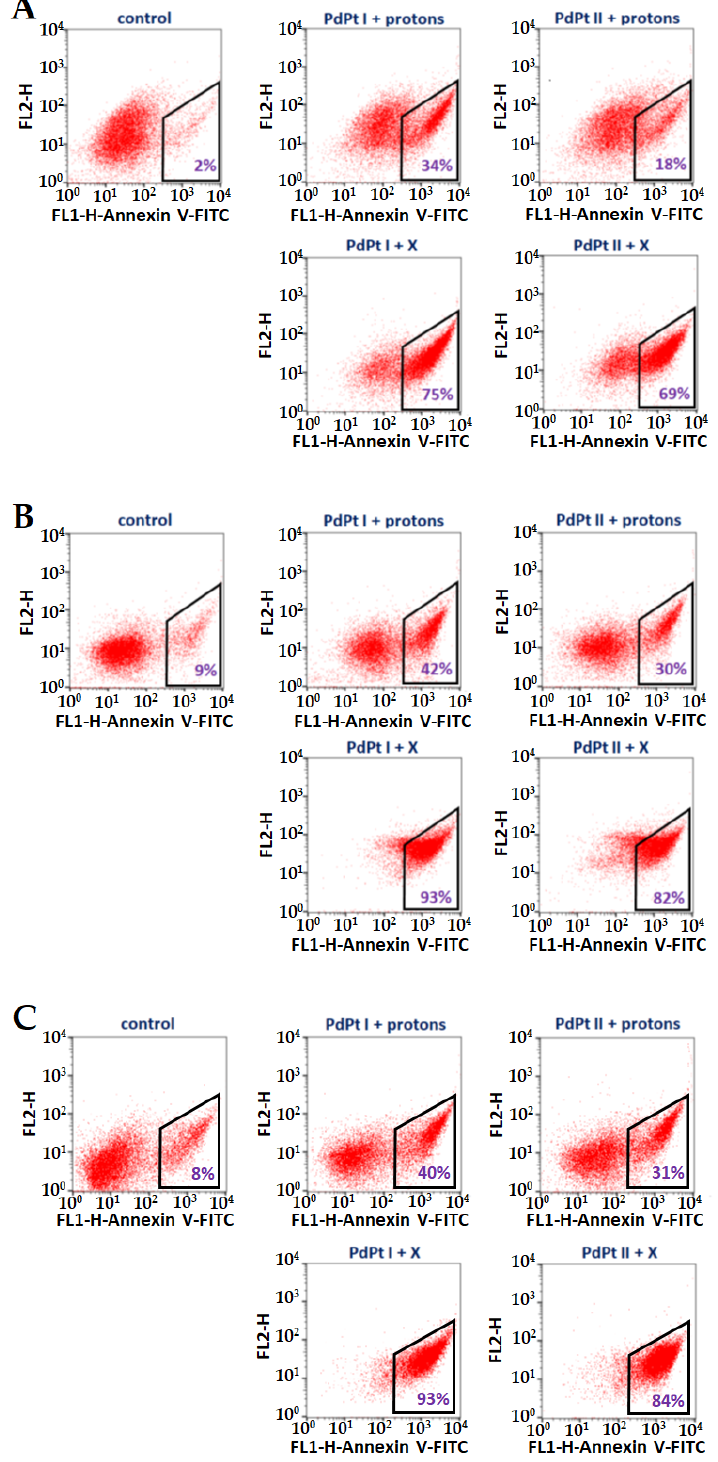
Figure 8. Flow cytometry analysis of Annexin V-binding - dot plots FL1-H vs. FL2-H show Annexin V-FITC stained ( A ) CCD 841 CoN, ( B ) SW480 and ( C ) SW620 cells after the addition of PdPt NPs, followed by proton or X-ray irradiation. The percentage of apoptotic cells is marked in violet.